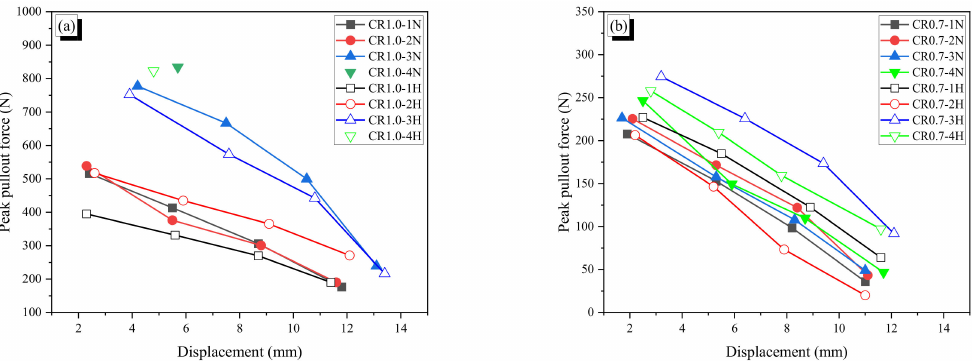
Figure 15. Peak pullout resistance with displacement: ( a ) CR1.0 fibers; ( b ) CR0.7 fibers.